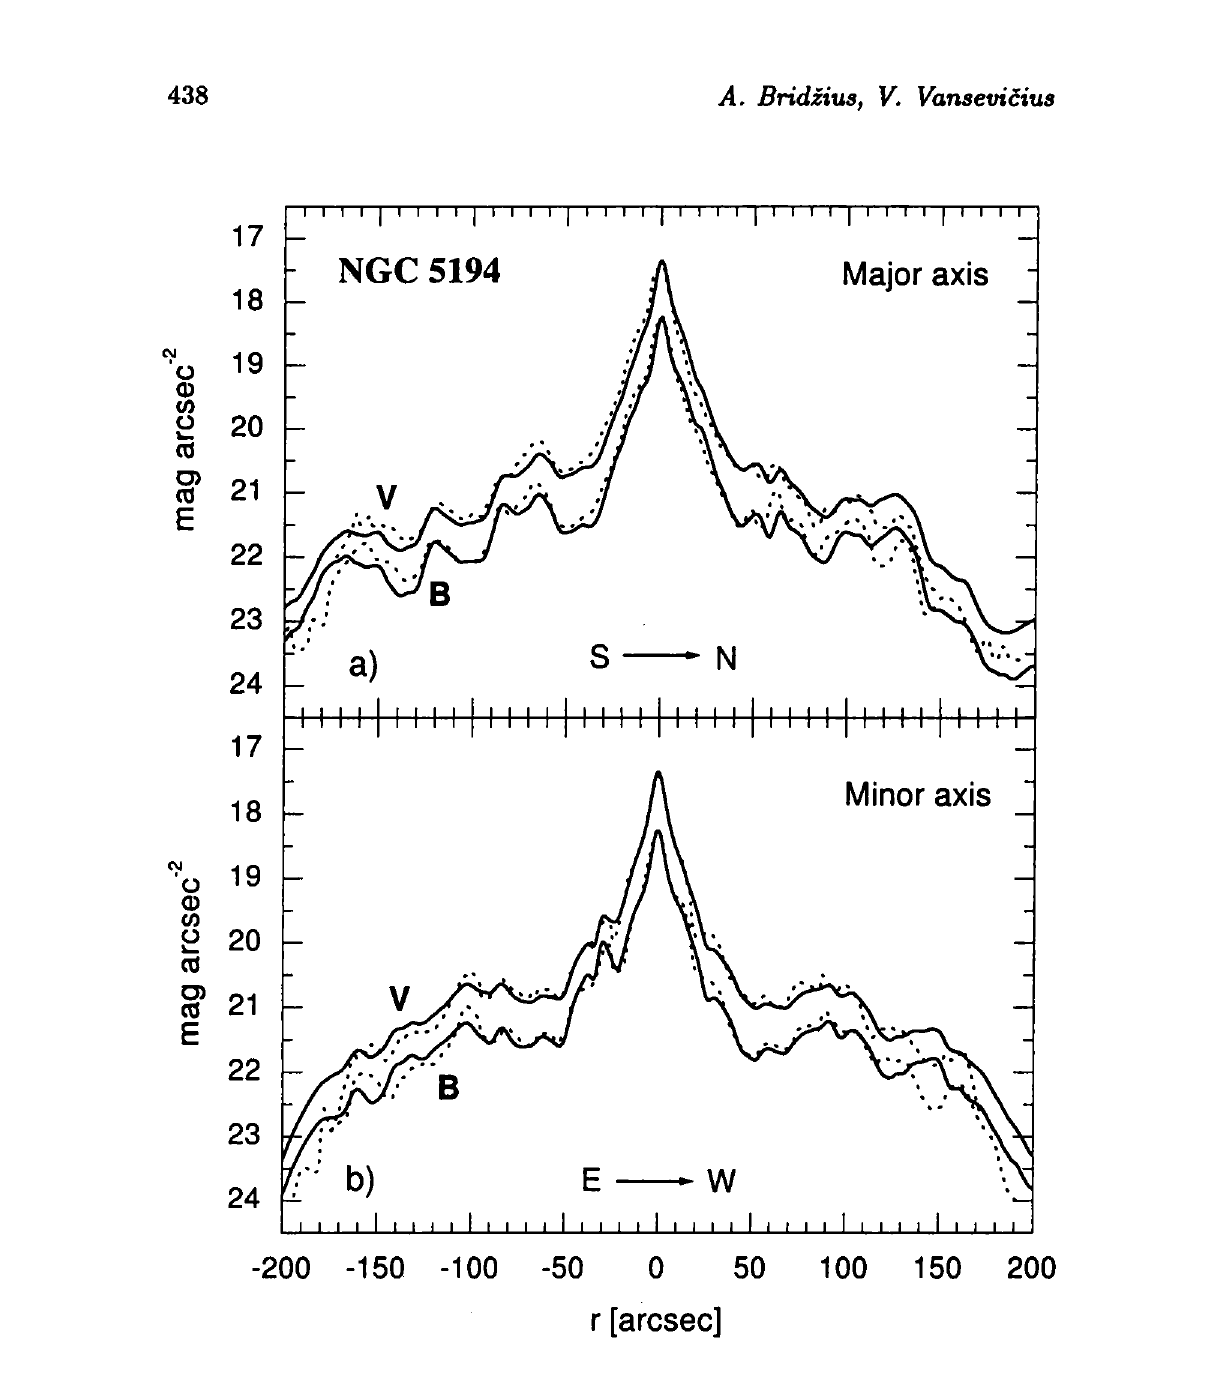
Fig. 10. Comparison of synthetic photometric scans of NGC 5194 along the major (a) and the minor (b) axes. Solid line - this work, dashed line - Okamura at al.